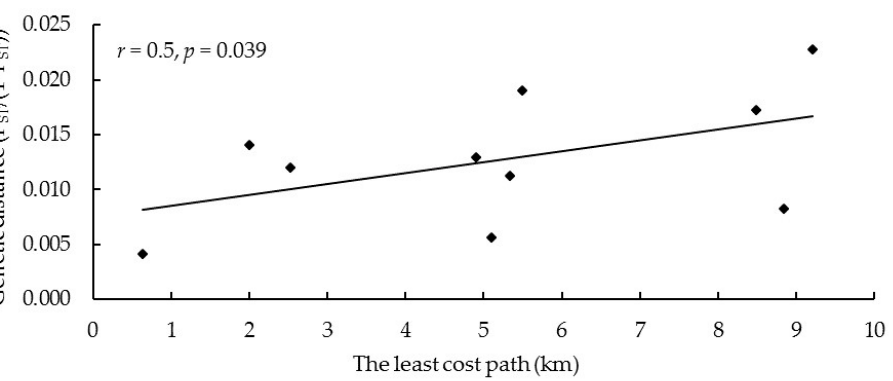
Figure 8. Mantel test of the least-cost path and genetic distance between five sampling sites based on the microsatellite data.